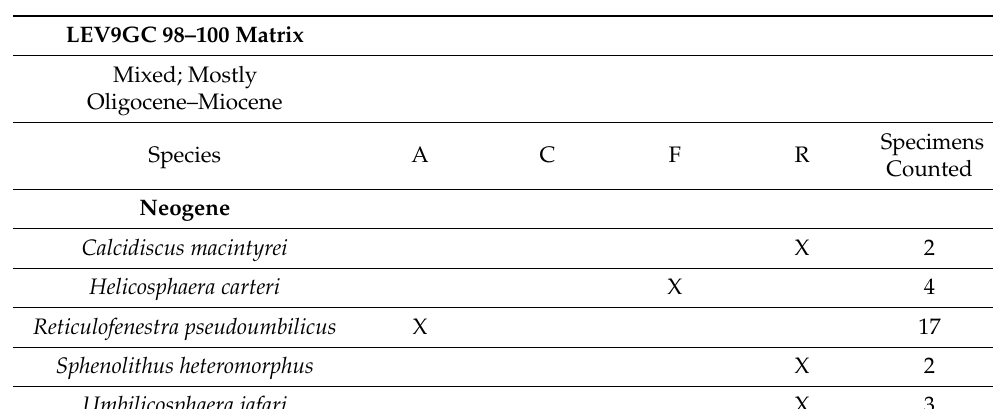
Table A40. Leipzig